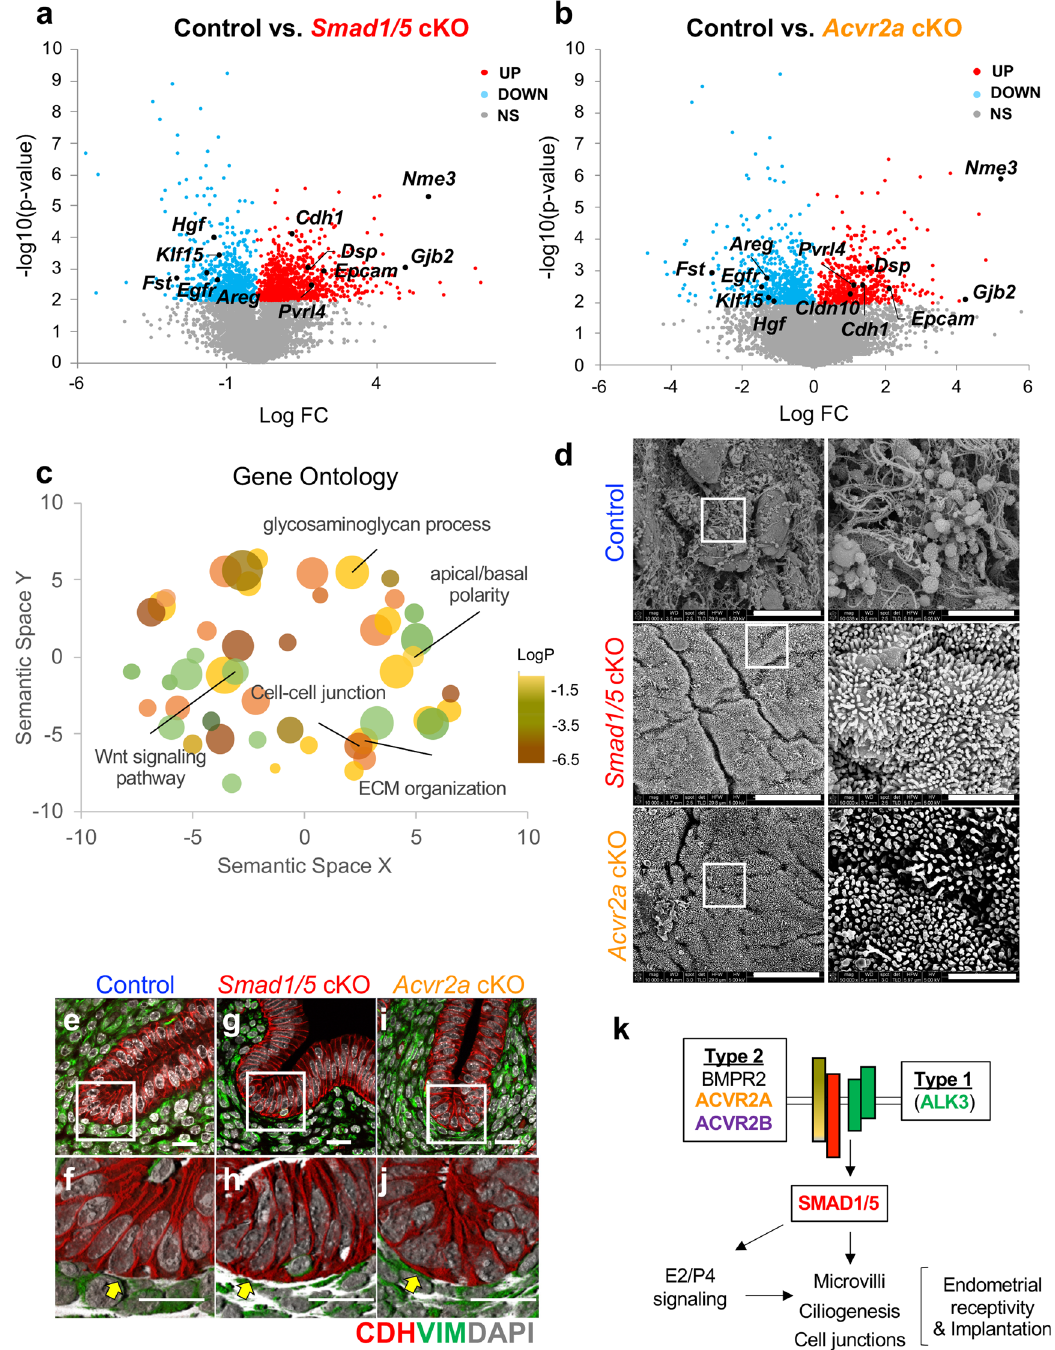
Fig. 6 Shared signaling pathways between Smad1/5 cKO and Acvr2a cKO mice reveal abnormal retention of apicobasal polarity and defective endometrial receptivity. a – b Volcano plots of differentially expressed transcripts determined by RNAseq between control vs. Smad1/5 cKO ( a ) and control vs. Acvr2a cKO ( b ) in the uterine tissues of 3.5 dpc pseudopregnant mice. Red, upregulated (fold change >1.4, p < 0.01 by paired, two-tailed, t test); blue, downregulated (<0.6, p < 0.01); labeled genes share differential expression in both genotypes. c Gene ontology classi fi cation of the shared genes in Smad1/ 5 cKO and Acvr2a cKO mice that are differentially expressed vs. controls. Bubble size and colors are plotted relative to p values, whereas the location in the scatterplot represents functional categorization. d Scanning electron microscopy analysis of the surface of the luminal uterine epithelium of 3.5 dpc control, Smad1/5 cKO, and Acvr2a cKO mice. Size bars = 10 µ m (left) or 2 µ m (right). Images in d are representative images obtained from analyses of three samples per genotype. e – j Immuno fl uorescence of the uterus of control ( e – f ), Smad1/5 cKO ( g – h ) and Acvr2a cKO ( i – j ) mice at 3.5 dpc of pseudopregnancy. Tissues were stained with E-cadherin (red), vimentin (green), and DAPI (white), e, g, i are confocal z-stacks; f , h , j , are 3D-renderings of the z-stacks. Yellow arrows in the control uterus ( f ) indicate that E-cadherin immunoreactivity was decreased in the basal region of the luminal epithelium of control mice but maintained in the Smad1/5 cKO ( h ) and Acvr2a cKO ( j ) mice. Size bars are 20 µ m. e – j are representative images of at least three samples analyzed per genotype. k Schematic of the BMP signaling pathway that is active during the window of implantation.